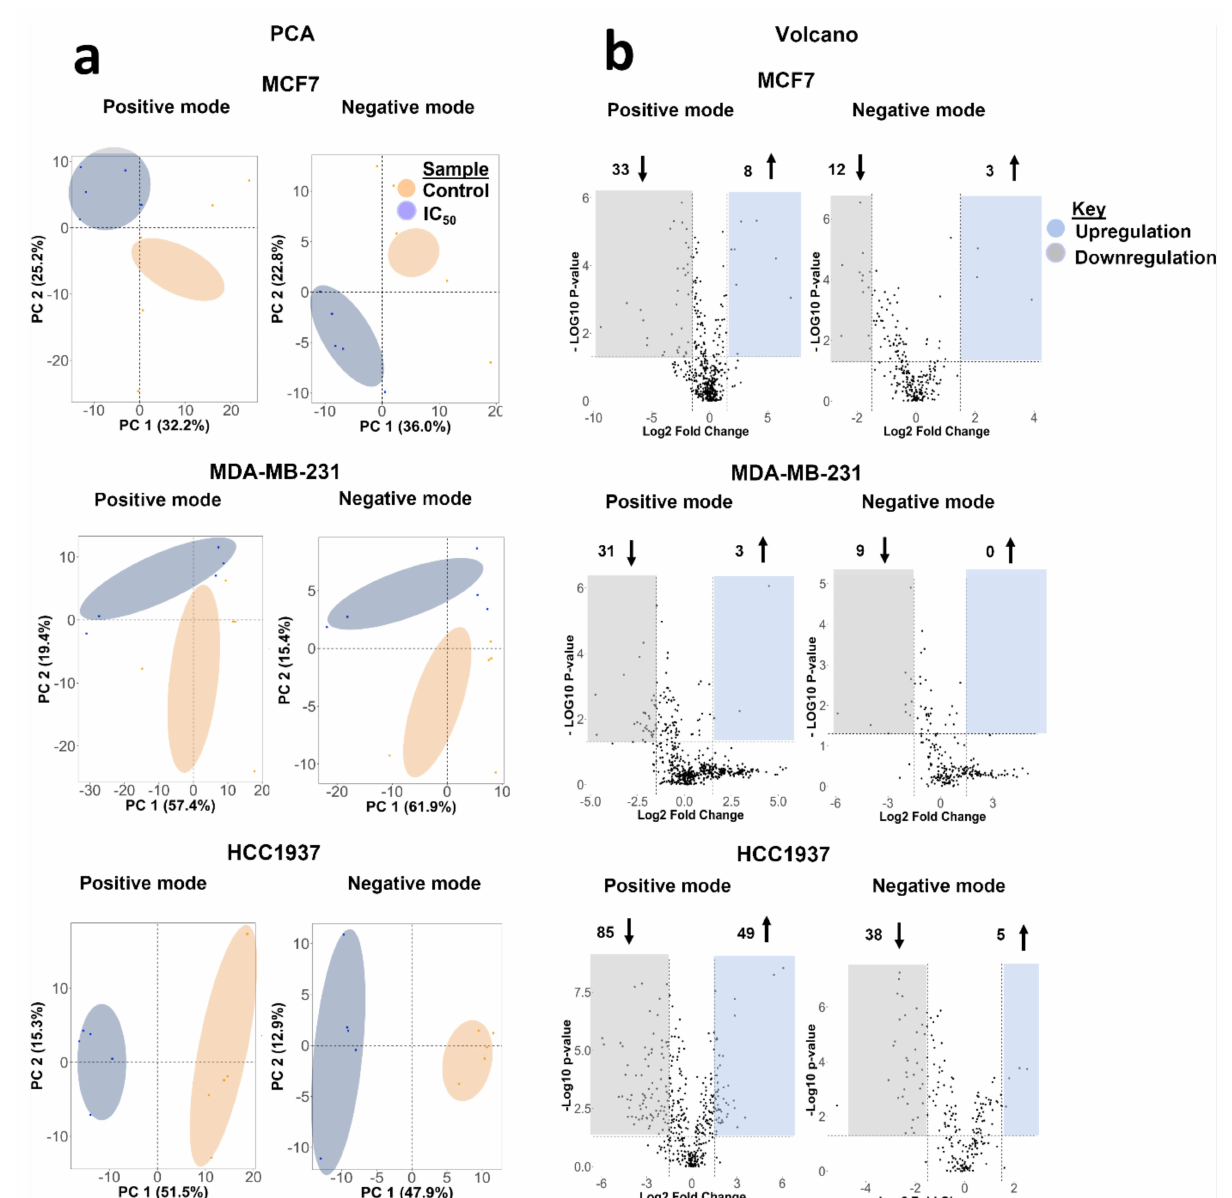
Figure 4. Statistical analyses of global metabolic features identified in MCF7, MDA-MB-231, and HCC1937 upon exposure to the IC 50 olaparib dose for seven days acquired in positive and negative ionization mode. For each treatment group, five replicates were used. Data points in the two- dimensional PCA score plot were central scaled. ( a ) PCA pairwise analysis and differential analysis of metabolites altered in IC 50 -treated cells, ( b ) Volcano plots displaying enriched (blue) and depleted (grey) metabolic features by representing the log2 fold change in altered features and the − log10 adjusted p -values with cut off values selected at >1.5 and <0.05, respectively. Upward arrows represent enrichment of features, while downward arrows represent depleted